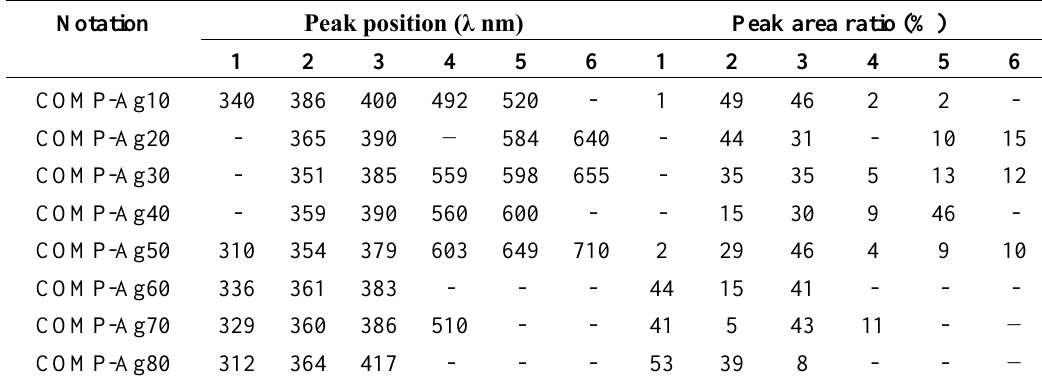
Table 1. The DRS peak positions and peak area ratios of Ag-NP/TiO films. These data were obtained by Gaussian curve-fitting using ORIGIN9 software (OriginLaB Co., Northampton,